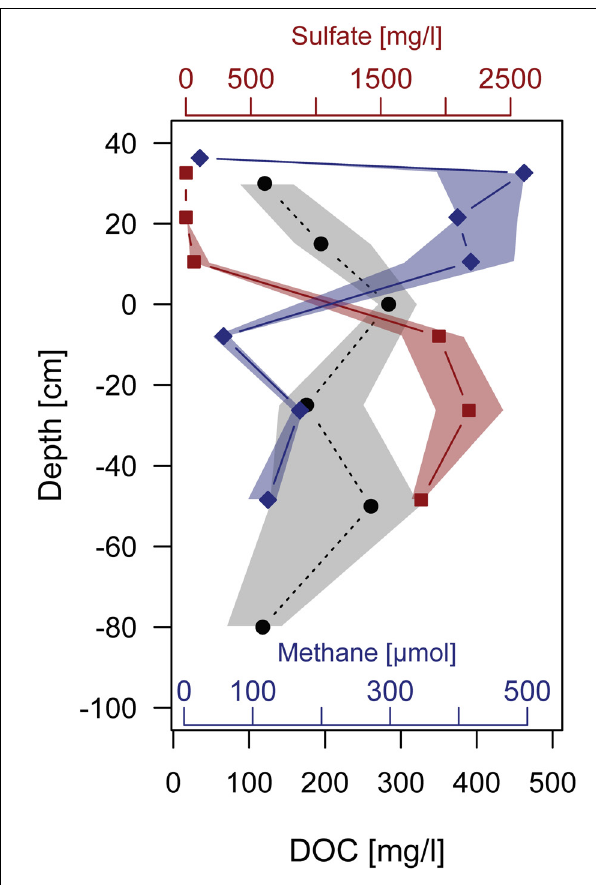
FIGURE 11 | (Pore) water profiles of DOC (black, circle), CH 4 (blue, diamond), and SO 4 (red, square) derived from repeated sampling in the central part of the peatland. Symbols denote median concentrations over monthly samples taken from May to October 2015, shaded polygons stretch from the 1st to the 3rd quartile of the distribution at the specific depths. Lines as well as shading contours are linearly interpolated between depths.